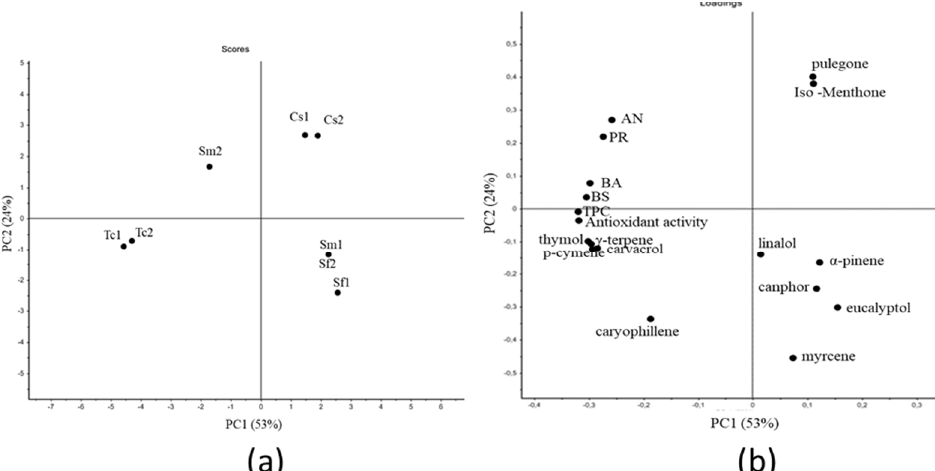
Figure 1. Principal component analysis (PCA) of data from the biological activity of EOs and their chemical characterization. ( a ) Score plot indicating sample distribution (EOs) basing on the biological activity and EO composition. ( b ) Loading plot indicating the correlation between variables: antimicrobial activity against A. niger (AN), P. roqueforti (PR), B. amyloliquefaciens (BA), and B. subtilis (BS); total phenol content (TPC); antioxidant activity; concentration of the single compounds (thymol, carvacrol, caryophillene, eucalyptol, canphor, α -pinene, γ -terpene, linalool, myrcene, p-cymene, pulegone, and iso-menthone) for each